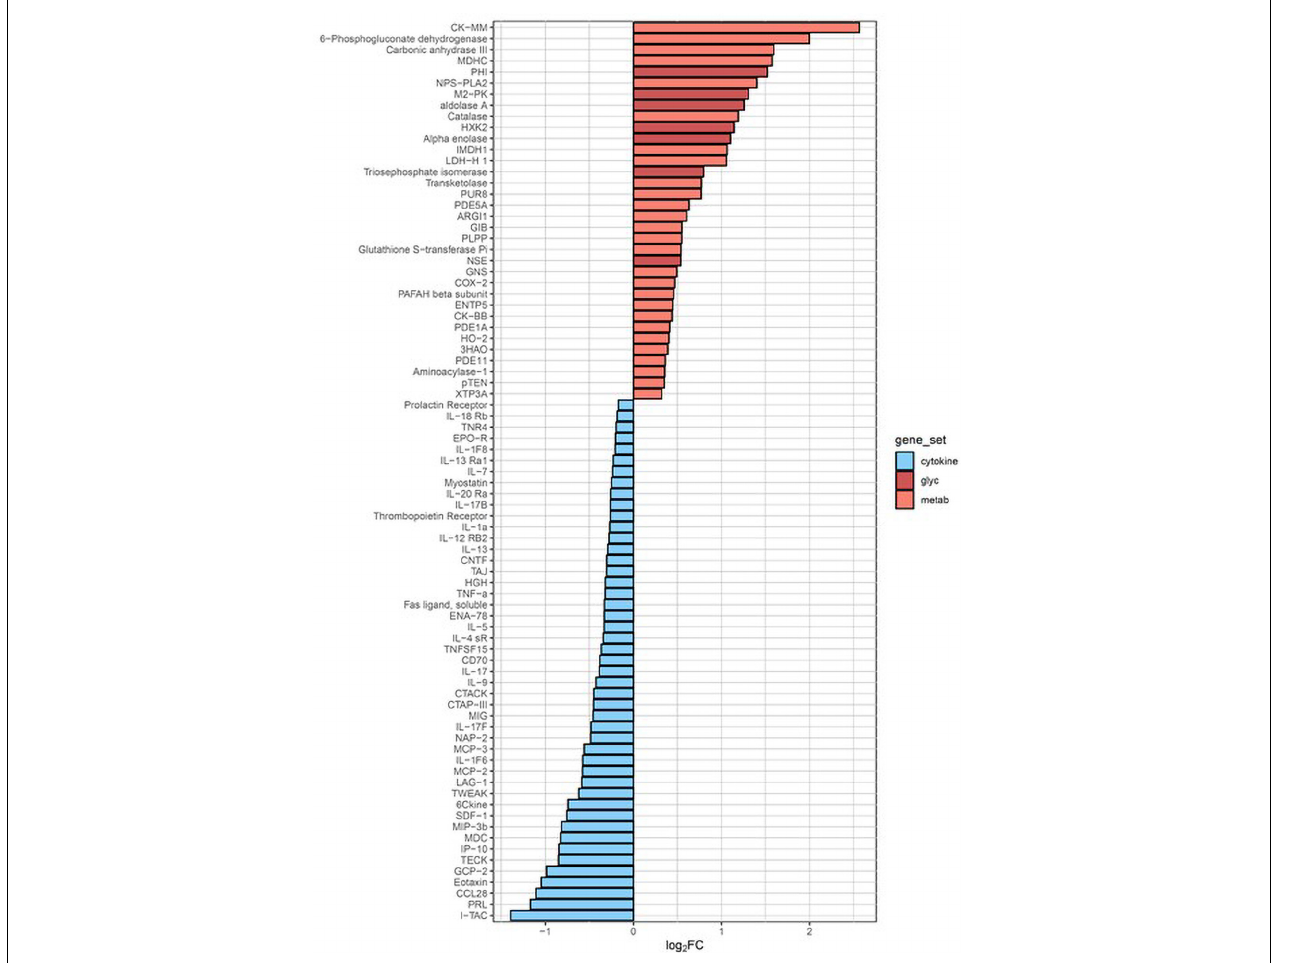
FIGURE 3 | KEGG pathway analysis. The two biological pathways most altered by cardiopulmonary bypass surgery involve upregulation of metabolism (red bars) and downregulation of cytokine–receptor interactions (blue bars). The dark red bars all represent enzymes of glycolysis. PHI, glucose-6-phosphate isomerase; M2-PK, pyruvate kinase isozyme M2; HXK2, hexokinase 2; NSE, neuron-specific enolase.